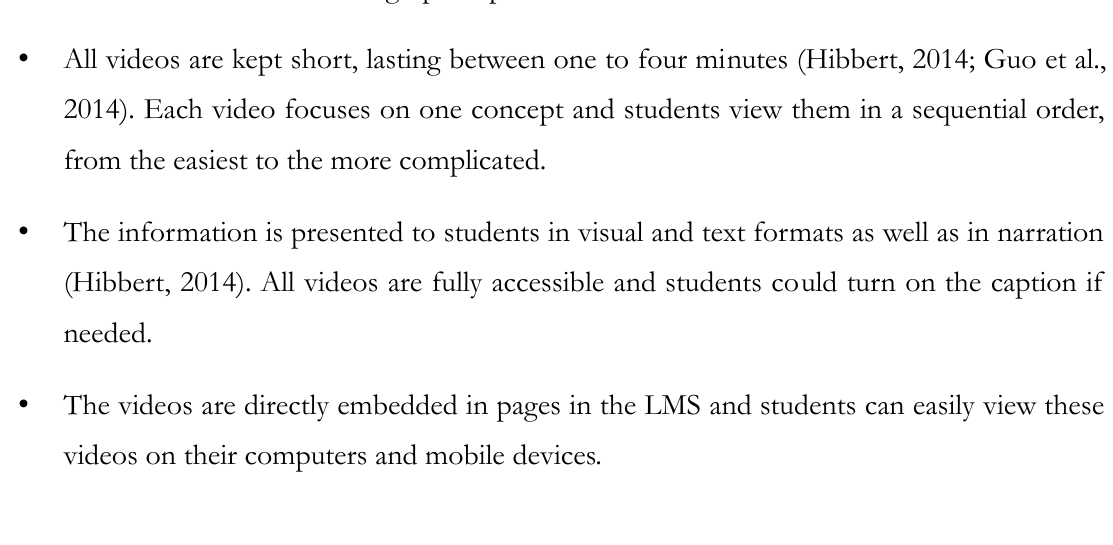
Figure 5. Summation of the three signals y